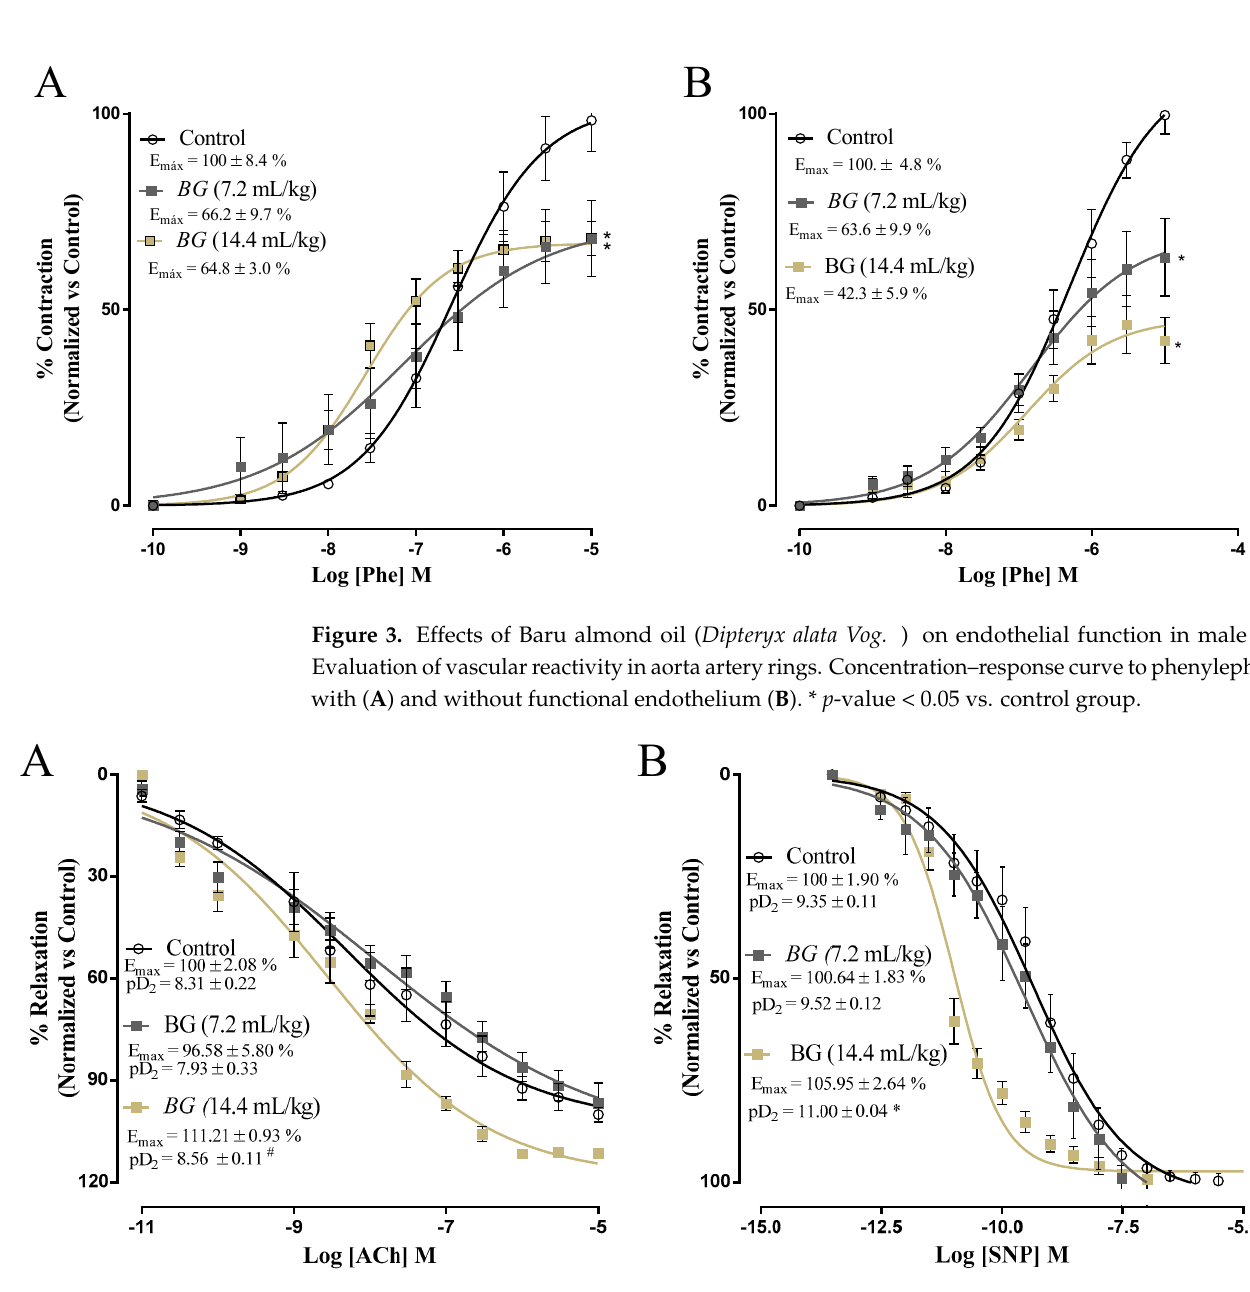
Figure 4. Effects of Baru almond oil ( Dipteryx alata Vog . ) on endothelial function in male rats. Evaluation of vascular reactivity in aorta artery rings. Concentration–response curve for acetylcholine (Ach, A ) in rings with functional endothelium and dose–response curve for sodium nitroprusside (SNP, B ) in rings without functional endothelium. * p -value < 0.05 vs. control group. # p -value < 0.05 vs. BG 7.2 mL/kg group.